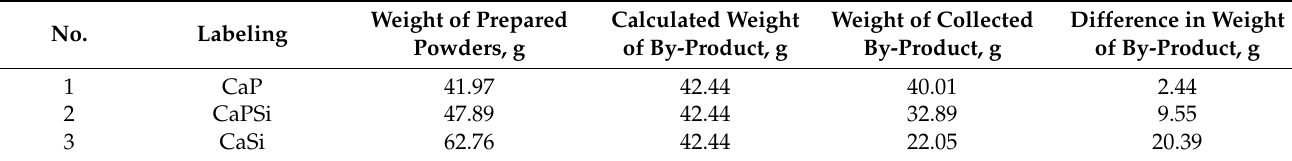
Table 2. Weights of prepared powders and